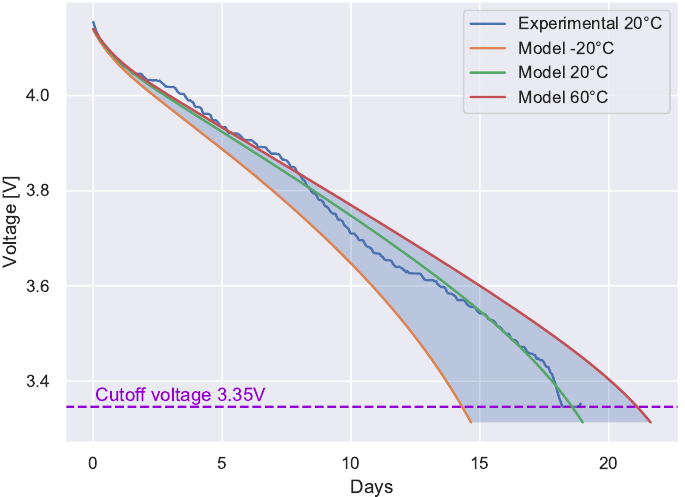
Figure 8. Tinovi PM-IO-5-SM with Li-ion batteries: discharge curves obtained from both experimental measurements and theoretical model, with a transmission period of 5